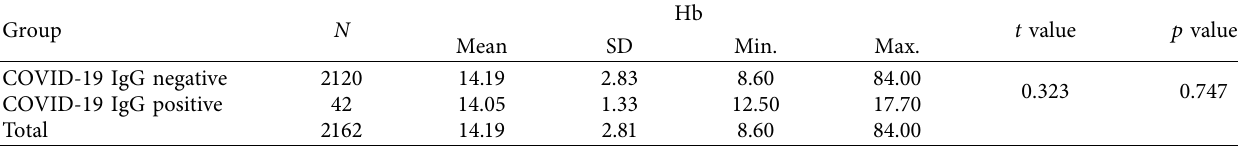
Table 5: COVID-19 IgG positive status among blood donors according to Hb status.